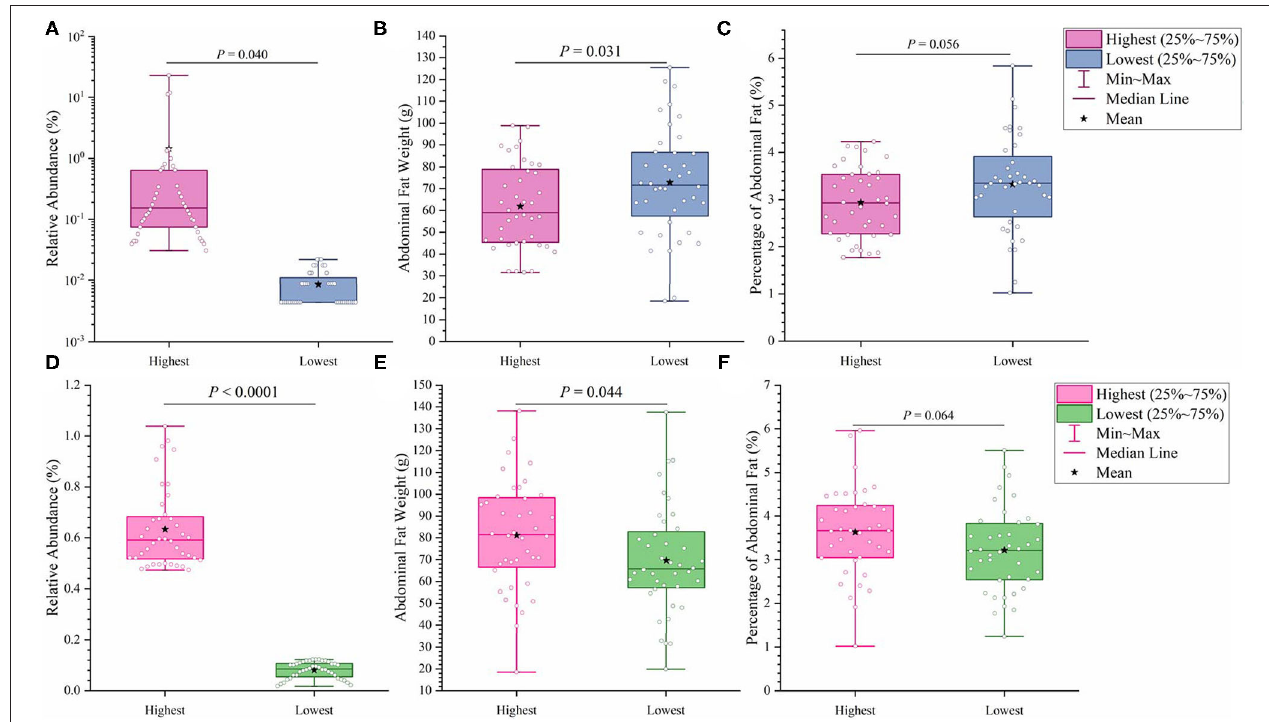
FIGURE 7 | Effects of fatness-related microbial genera, Treponema (A–C) and Ruminococcus_torques_group (D–F) , on host